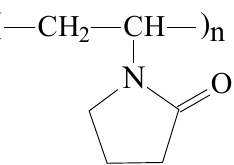
Figure 1. Structural formula of polyvinylpyrrolidone.